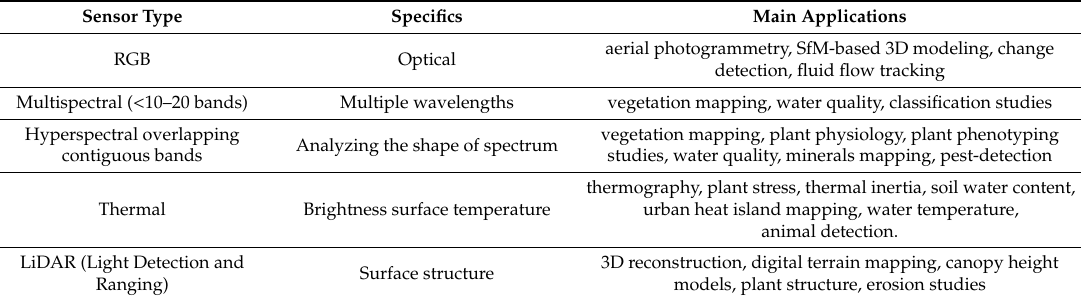
Table 2. Type of sensors mounted on UAS and their possible